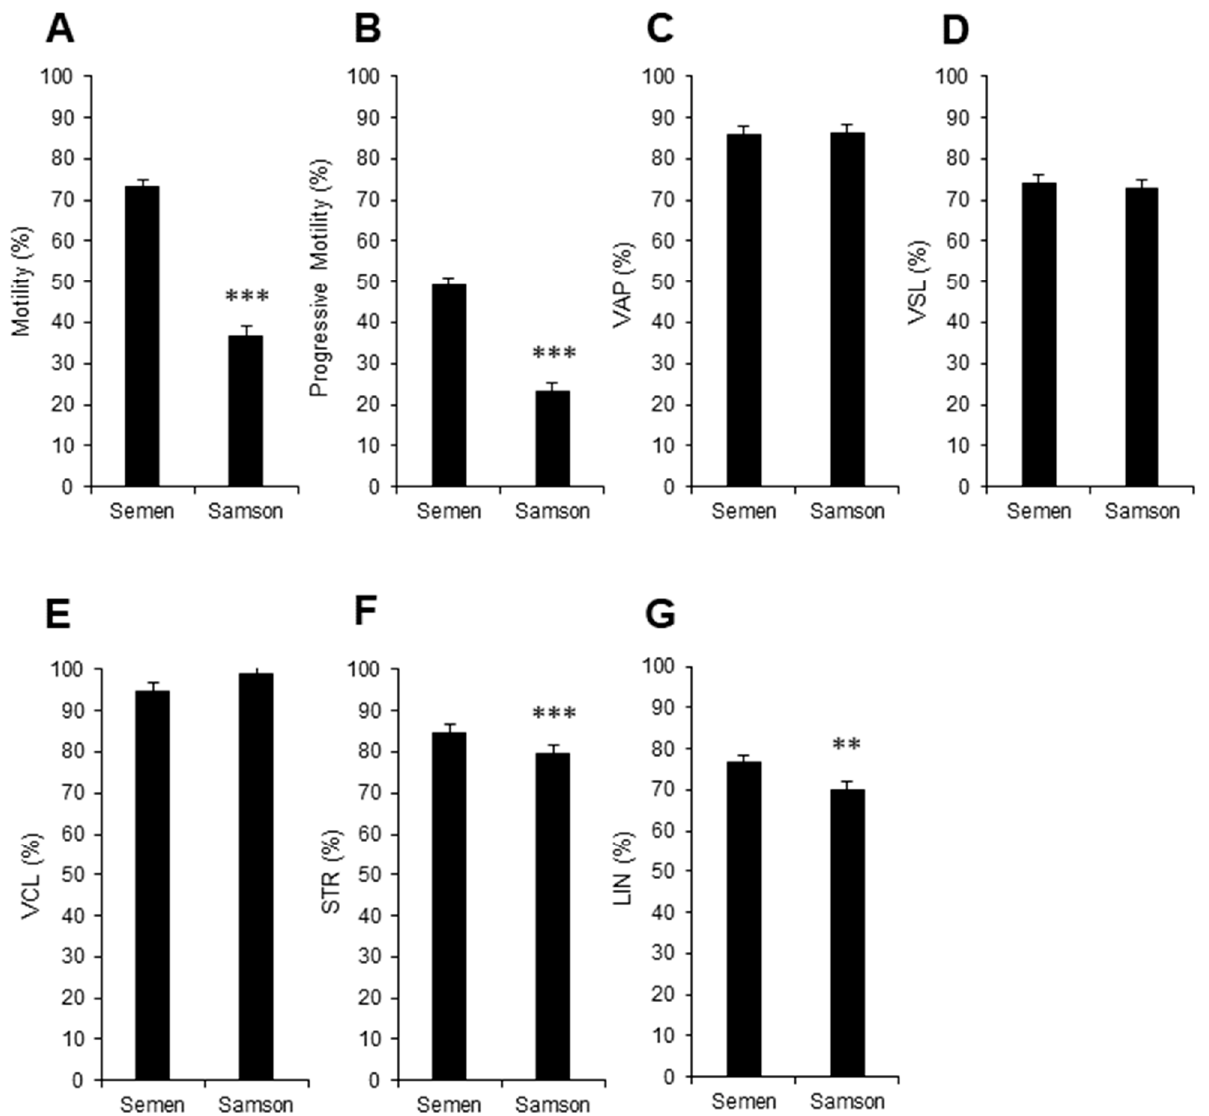
Figure 2. Isolation of stallion spermatozoa in a Samson™ chamber prior to chilling. ( A ) Total motility, ( B ) progressive motility, and sperm velocity parameters ( C ) VAP, ( D ) VSL, ( E ) VCL, ( F ) STR, and ( G ) LIN values of isolated samples (Samson) were compared with motility parameters from the parent population (Semen; ** p < 0.01; *** p <